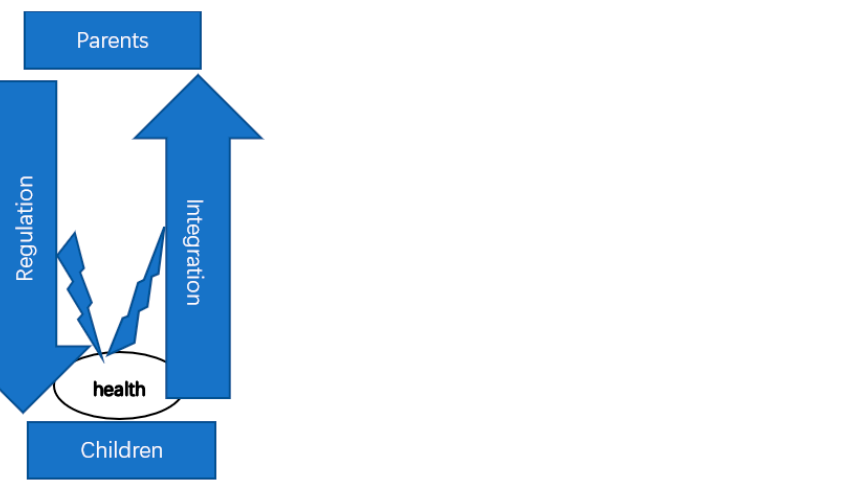
Figure 1. Conceptual Diagram for the Functions of Children’s Health in Family